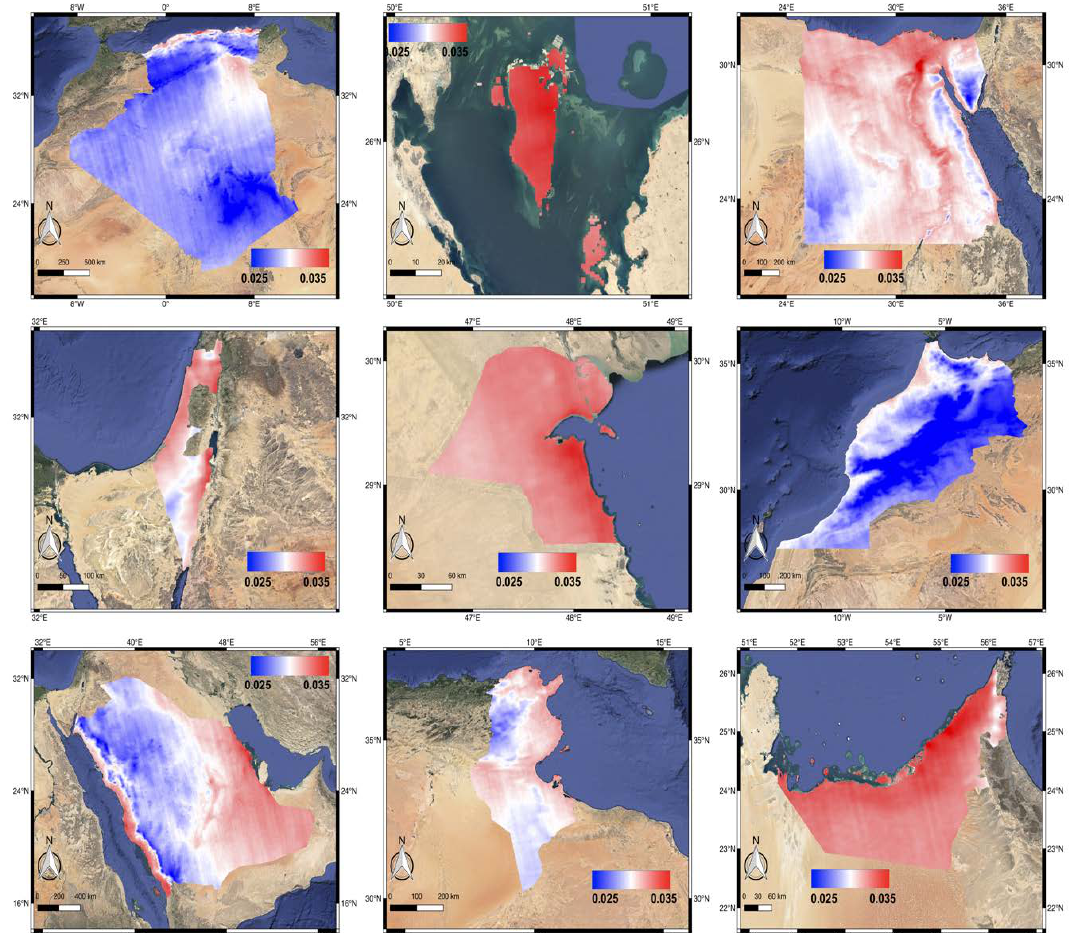
Figure 4. The annually averaged CO distribution map of nine MENA countries (from left to right, top to bottom: Algeria, Bahrain, Egypt, Israel, Kuwait, Morocco, Saudi Arabia, Tunisia, and UAE) from July 11, 2018 till July 10, 2019.